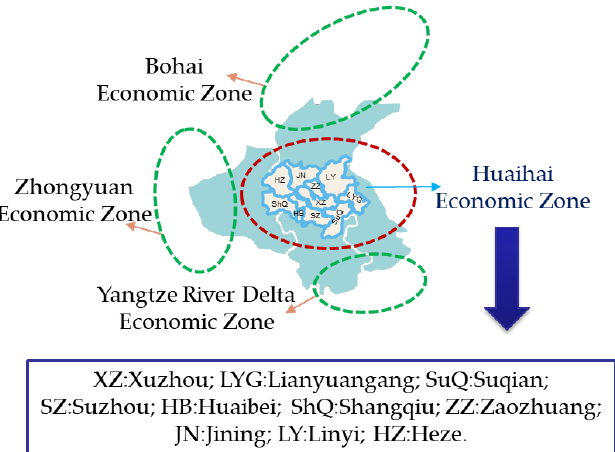
Figure 4. Location of Huaihai Economic Zone.